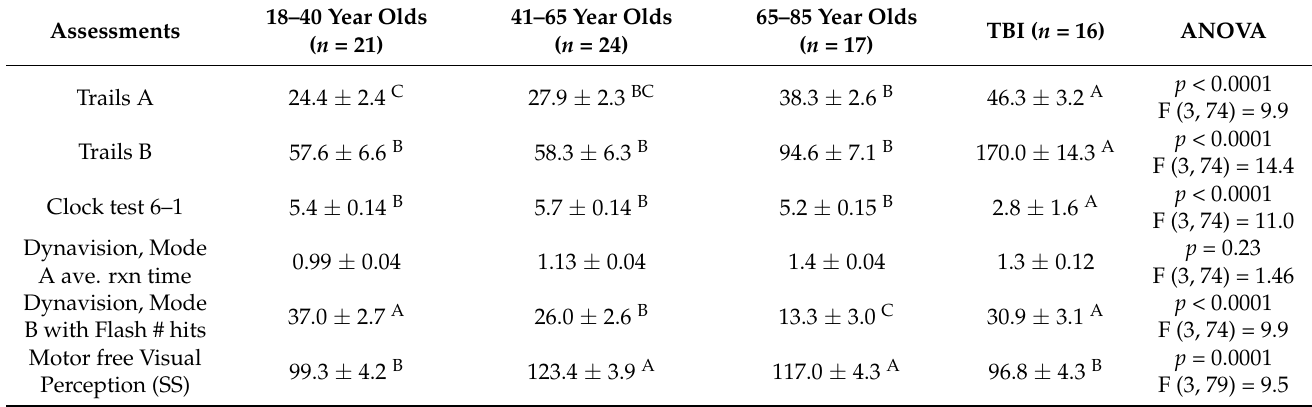
Table 3. Clinical